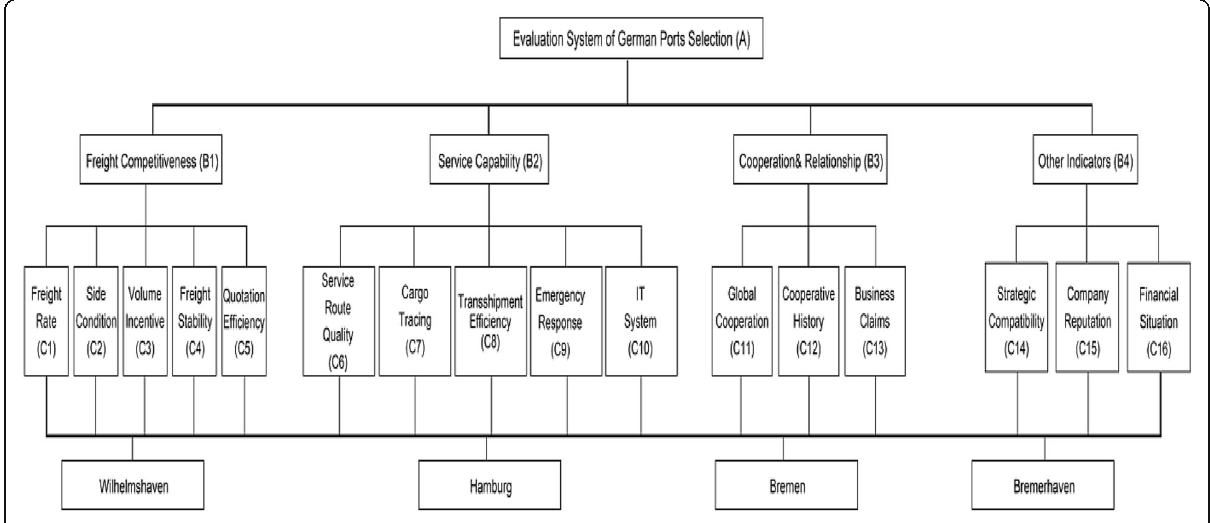
Fig. 4 Evaluation system of german ports selection. (Source: